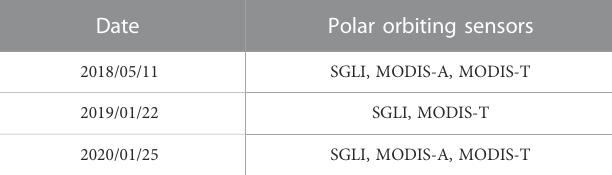
TABLE 3 A list of dates with polar orbiting sensors used in this